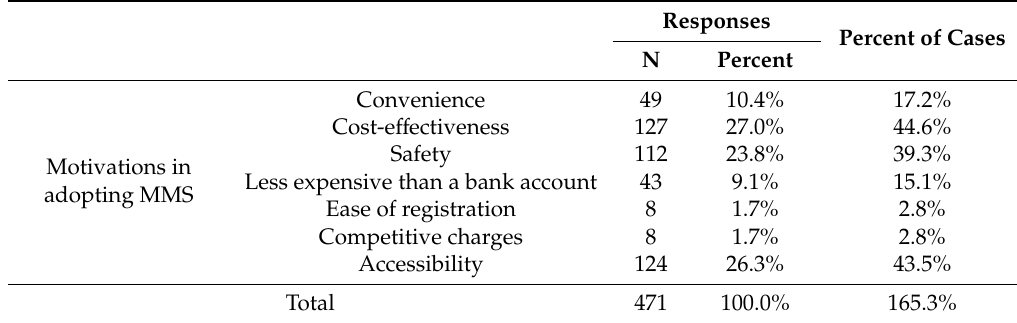
Table 2. Motivations of the respondents for electing to make use of Mobile Money Services